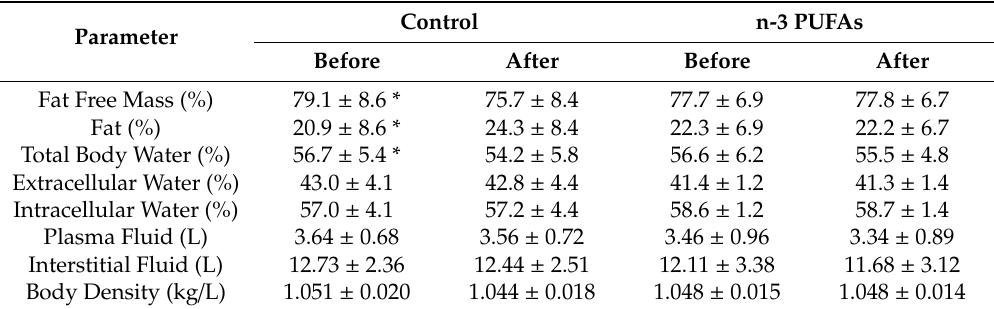
Table 4. Body composition and body fluid status responses to regular (Control group) and n-3 PUFAs enriched hen eggs (n-3 PUFAs group)